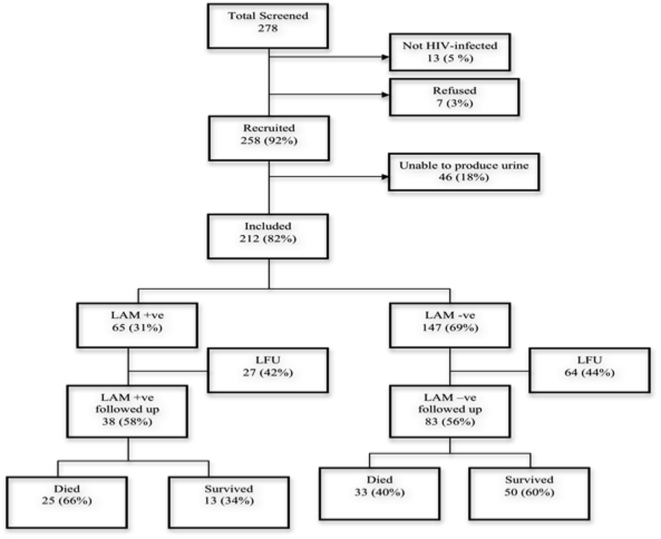
Mortality by LAM result.